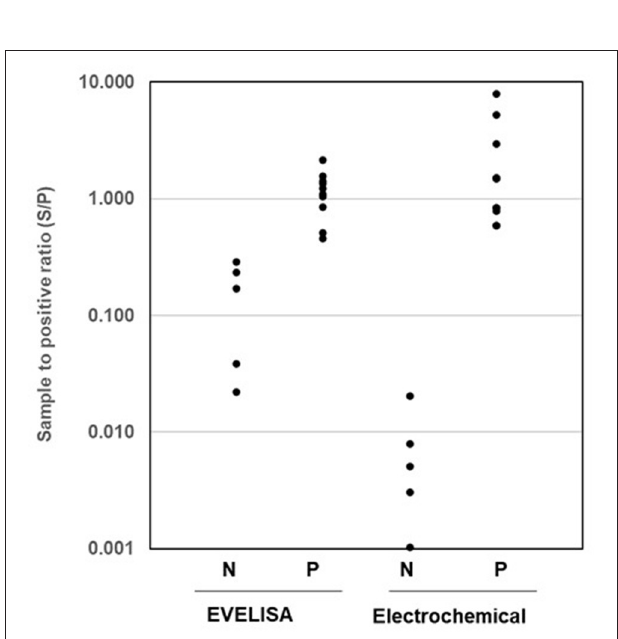
FIGURE 2 | Optimization of assay conditions for electrochemical measurement of HRP activity. The y-axis represents the reciprocal ratio (RR) values calculated as described in the method section. (A) Different voltages were applied to the interdigitated microelectrode (IDE) at the measurement of HRP activity. The experiment was conducted with three replicates. A similar result was obtained in a separate experiment. (B) Concentrations of ferrocyanide [1/8X (0.6mM), 1/16 (0.3mM), 1/32X (0.15mM), and 1/64 (0.08mM)] were added to the HRP–TMB reaction solution prior to the electrochemical measurement of HRP activity.